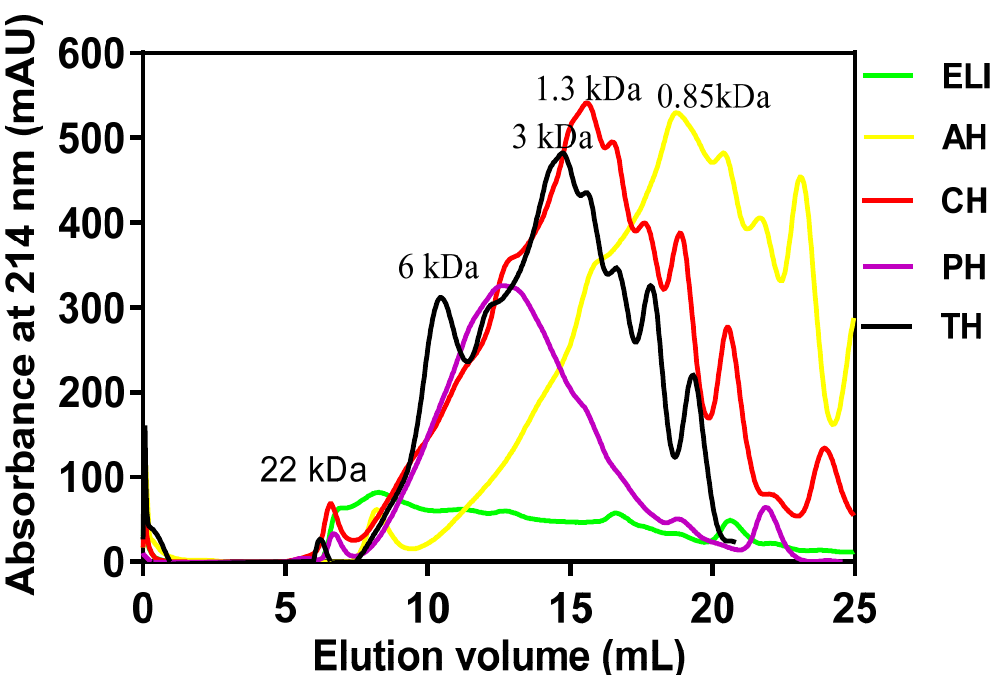
Figure 2. Comparative gel-permeation chromatograms of eggplant leaf protein isolate (ELI) and enzymatic protein hydrolysates: alcalase (AH), chymotrypsin (CH), pepsin (PH) and trypsin (TH). Inserted values indicate estimated molecular weights.